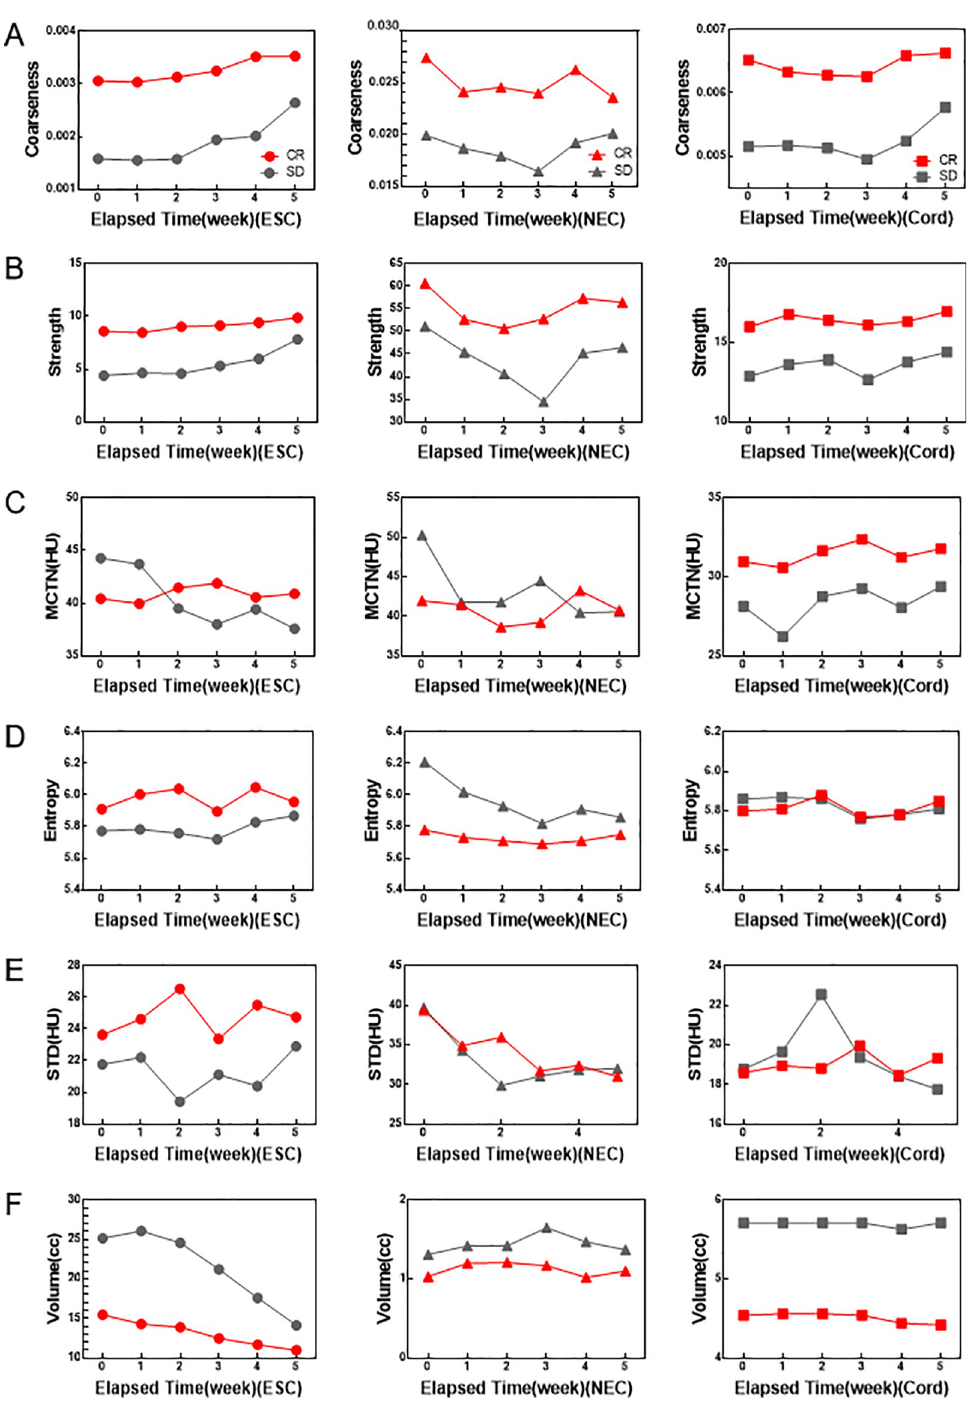
Fig 2. Changes in texture features with treatment. Coarseness (A), strength (B), MCTN (C), entropy (D), STD (E) and volume (F) were observed in patients with good response (CR) and poor response (SD) of ESC, NEC and cord with the elapsed